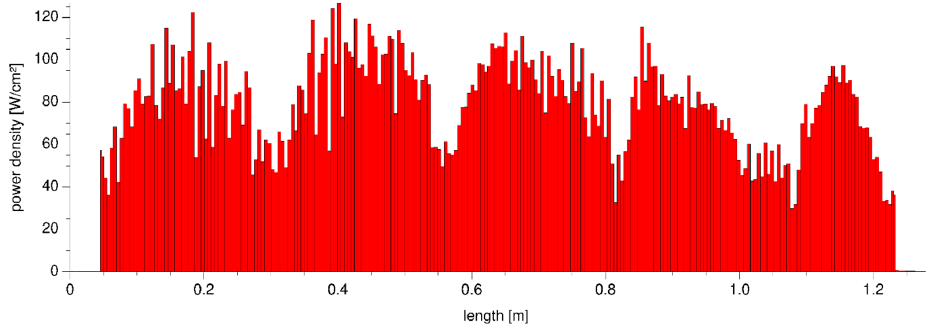
Figure 3. Expected power density on the cylindrical section of the load in the case of 1.5 MW injected power at a frequency of 140 GHz.